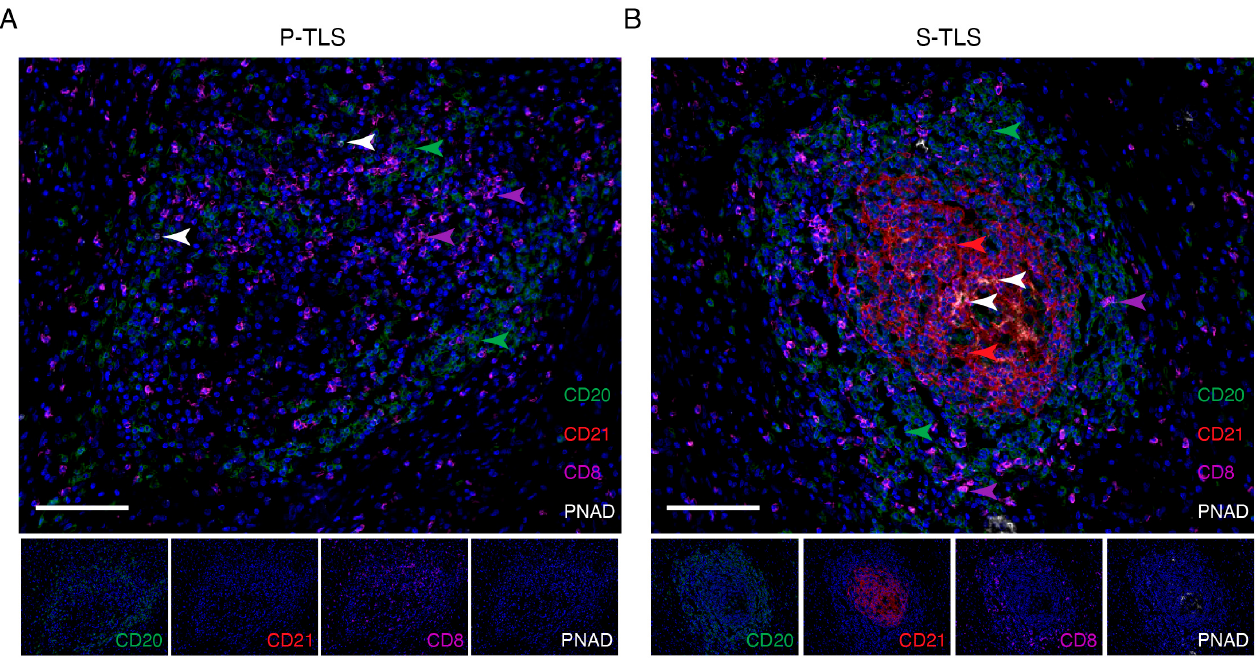
Figure 2. Representative images of multiplex immunofluorescence staining showing the cellular composition of primary and secondary TLSs in pCCA. CD20, CD21, CD8, PNAD, and DAPI were labeled as B cells (green), follicular dendritic cells (red), CD8 + T cells (pink), high endothelial venules (white), and nuclei (blue) in P-TLSs ( A ) and S-TLSs ( B ), respectively. The scale bar represents 100 μ m.